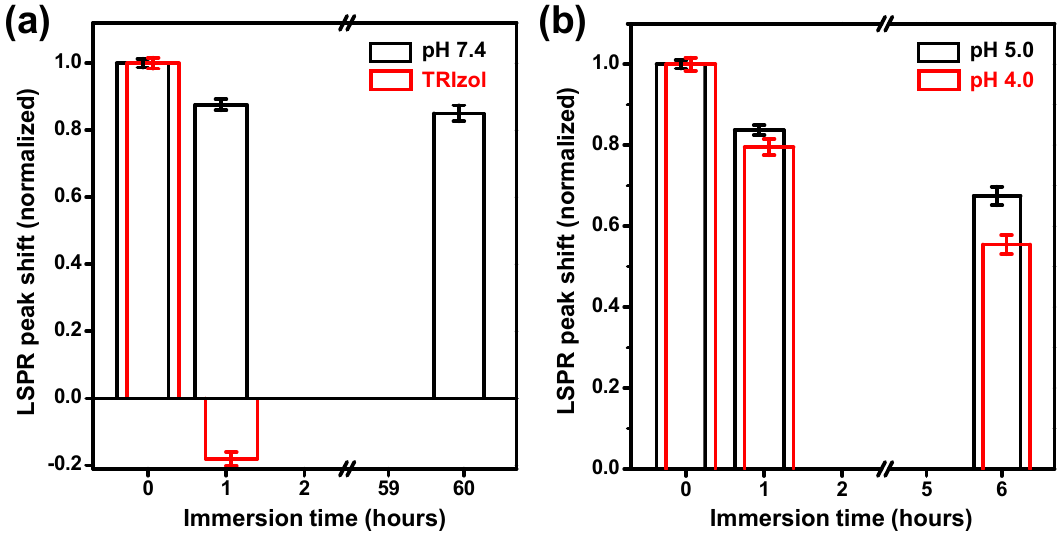
Figure 4. Normalized LSPR peak shifts measured by exosome-coated DAS arrays. After dip-coating thrice with exosomes, the samples were immersed in a TRIzol reagent (red bars in ( a )) and buffer solutions with pH 7.4 (black bars in ( a )), 5.0 (black bars in ( b )), and 4.0 (red bars in ( b )). The peak shifts were divided by the initial shift values, measured after dip-coating thrice with exosomes for each sample.